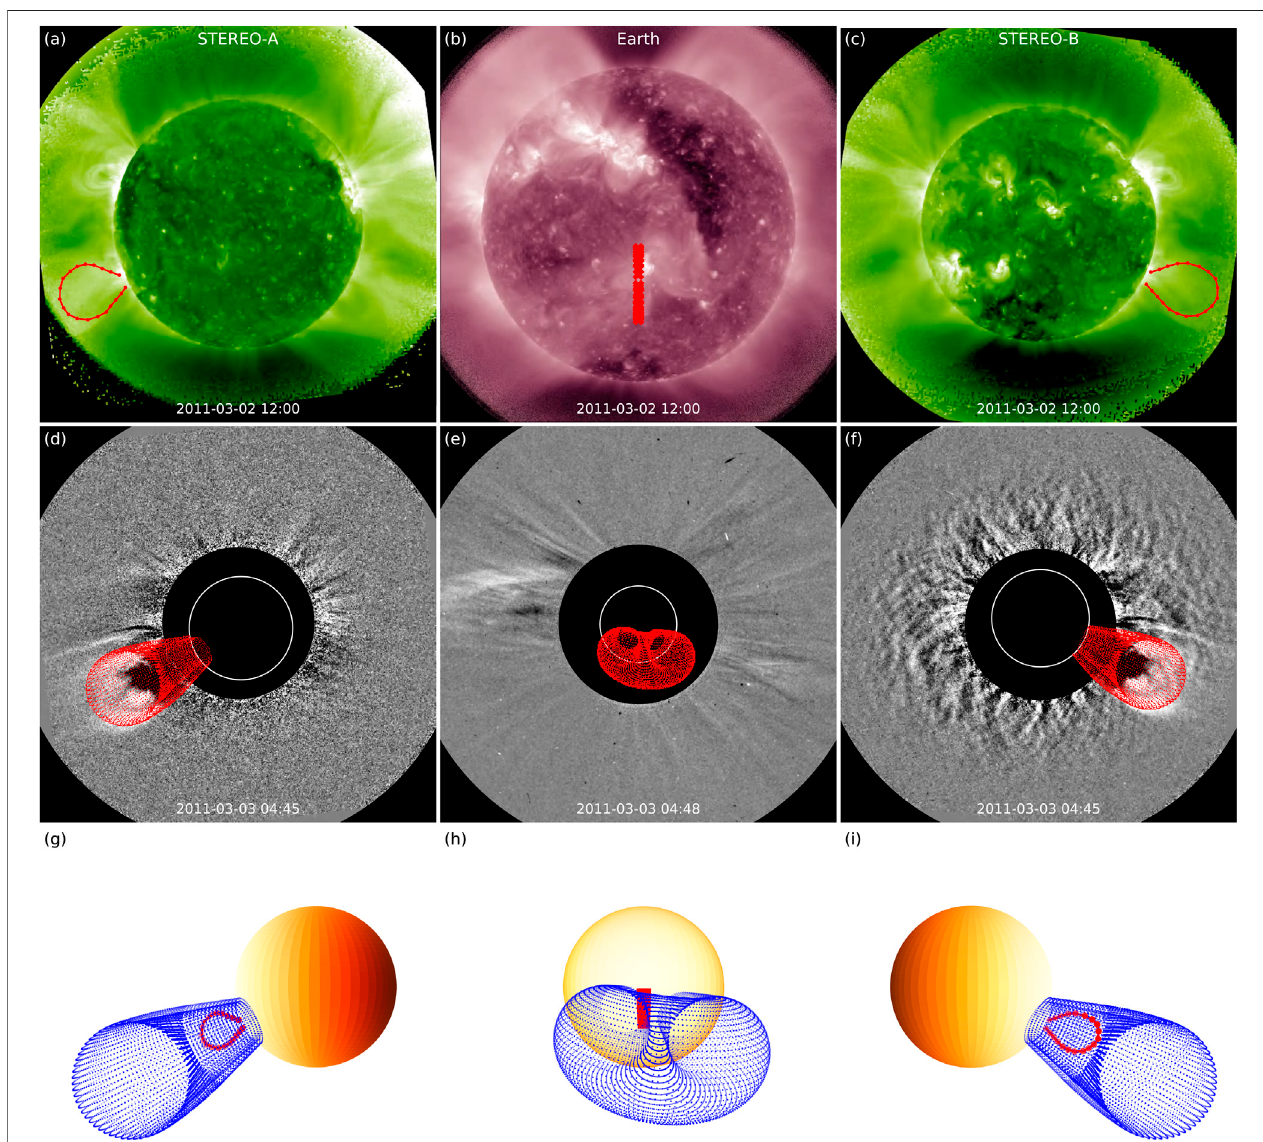
FIGURE4| Geometrictechniquesappliedtothe2011March3CME(Event2). (A – C) ApplicationoftheTPtechniquetothepre-eruptivestructure.Thetechniqueis appliedtoSTEREO-AandSTEREO-BimagesandthelatitudinalextentofthetriangulatedloopisprojectedontotheSDO/AIA fi eldofview(anddisplayedoverthecentral meridian). (D – F) GCS reconstruction applied to the white-light structure seen in STEREO-A, SOHO, and STEREO-B imagery. (G – I) Results of the TP and GCS reconstruction techniques displayed together in a 3D representation and shown from three viewpoints: STEREO-A, Earth, and